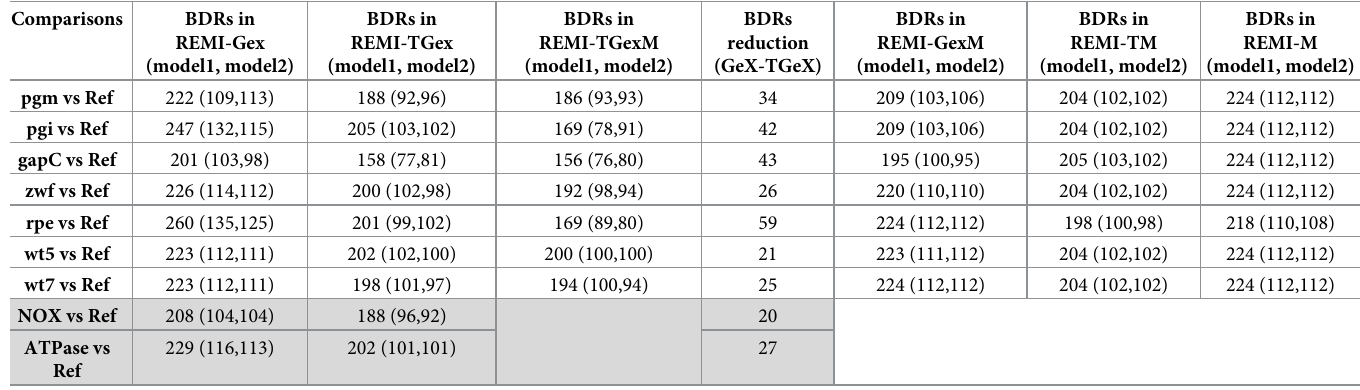
Table 3. Uni- and bidirectional reactions for the REMI-Gex and REMI-TGex models in the second E . coli study. Table entries are in the form of S (n1,n2), where n1 is the number of bidirectional reactions for the mutant model, n2 represents bidirectional reactions for the reference model, and S represents the sum of n1 and n2.